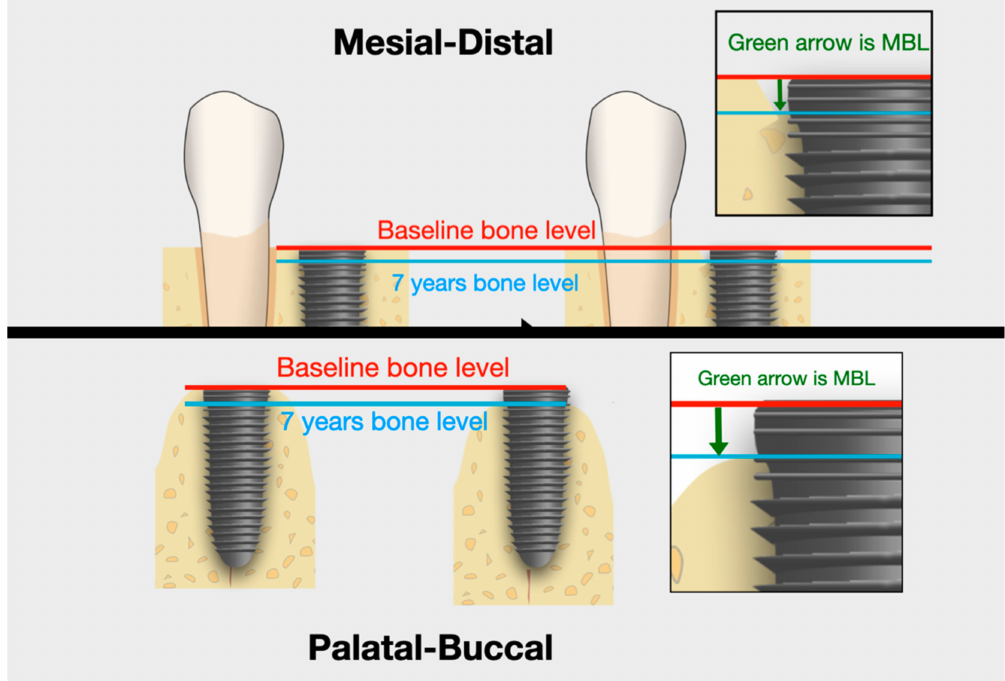
Figure 4. Marginal bone level (MBL) measuring points on CBCT were located around the implant platform (four points around each mesial, distal, buccal, and palatal).